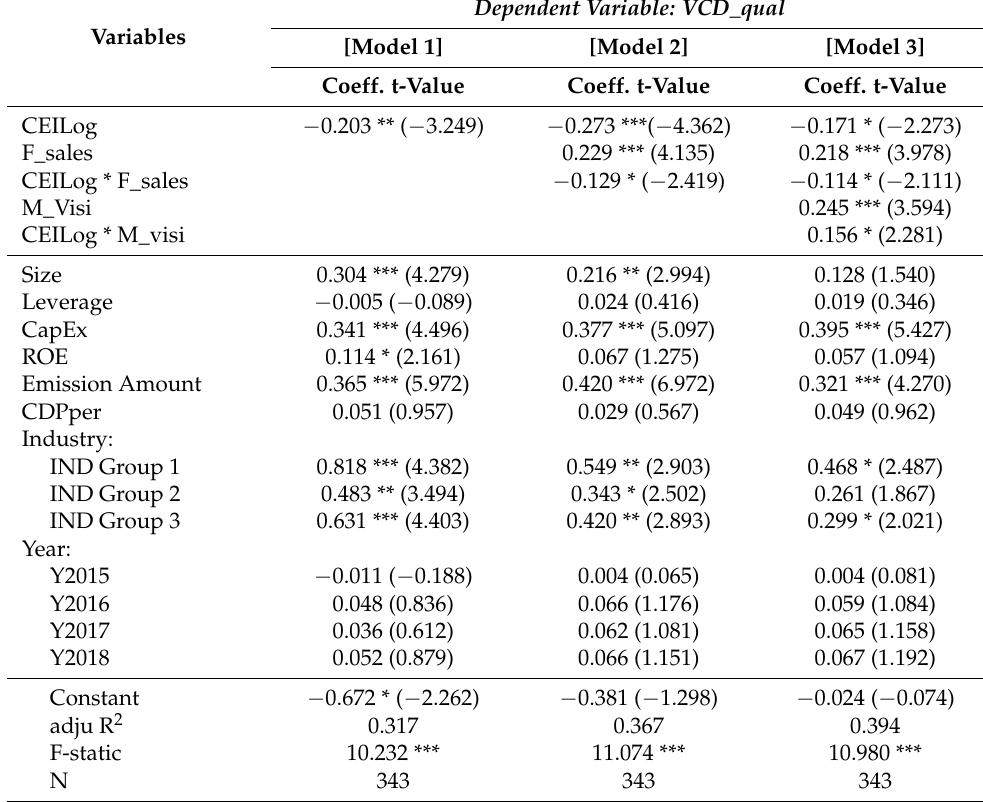
Table 6. Regression